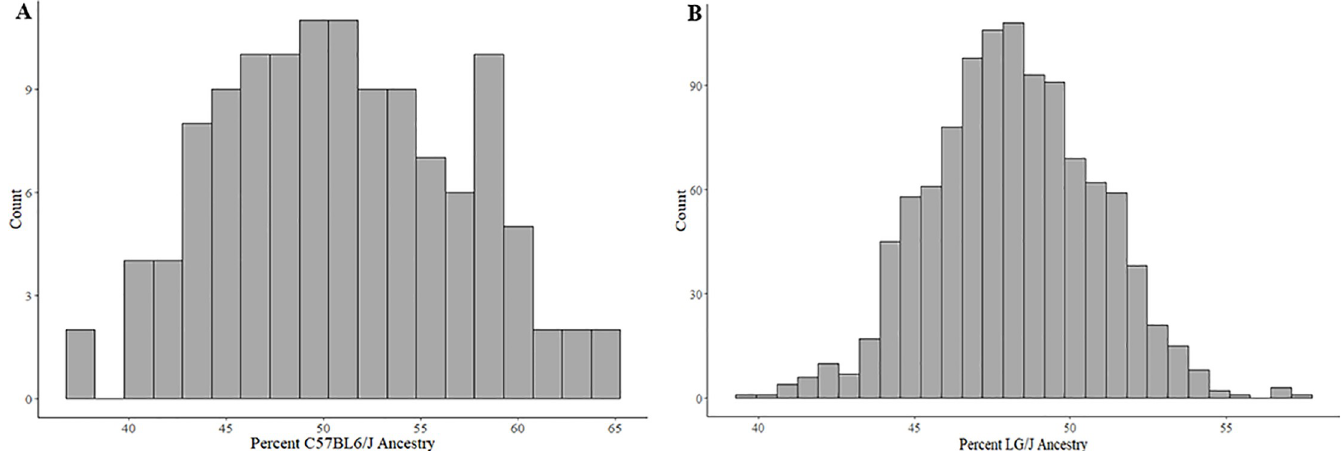
Fig 2. Ancestral strain contributions by strain. A) The 122 strains of the RI panel of the HMDP, B) The 1063 animals in the F 50 –F 56 generation of the AIL Cross.